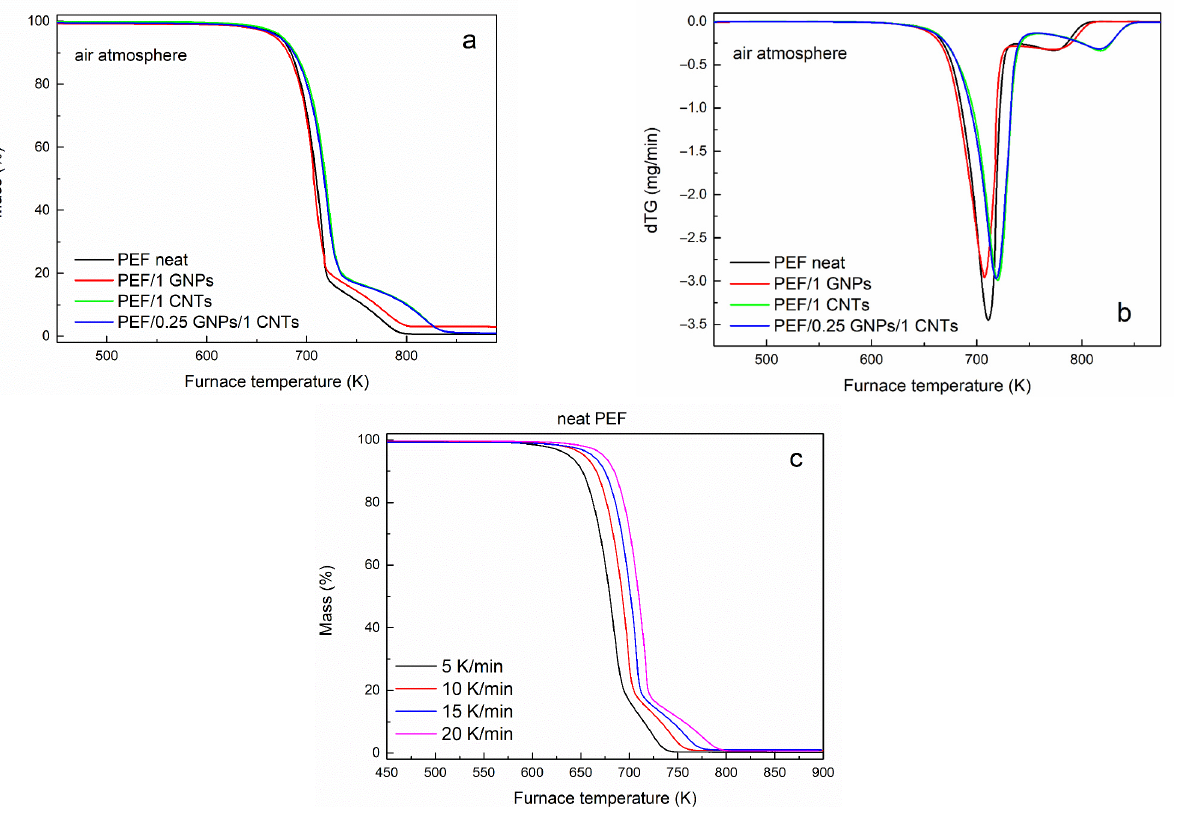
Figure 6. Mass loss curves of ( a ) neat PEF, PEF/1 GNPs, PEF/1 CNTs, and PEF/0.25 GNPs/1 CNTs nanocomposites and ( b ) its first derivative, versus temperature at a heating rate of 20 K/min, and ( c ) neat PEF at 5, 10, 15, and 20 K/min heating rates versus temperature under dry air atmosphere. Table 7. Temperatures at 2% and 50% mass loss and the peak temperatures of the dTG curve of neat PEF and its nanocomposites under a dry air atmosphere.